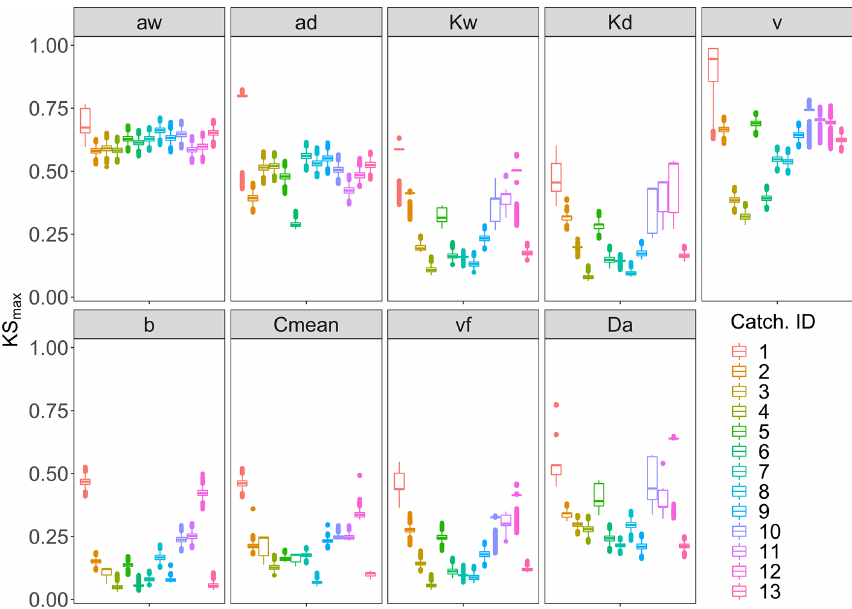
Figure 4. The KS max sensitivity index for each of the model input parameters and each of the 13 simulated catchments. The input parameters related to the channel geometry ( a d , a w , K d and K w ), land-to-stream loading ( b and C mean ) and biogeochemistry ( v f ) are shown together with two variables derived from some of the input parameters: the median velocity v and the Damköhler number Da. Each boxplot displays 15000 bootstrapped estimates of KS max for each of the 13 simulated